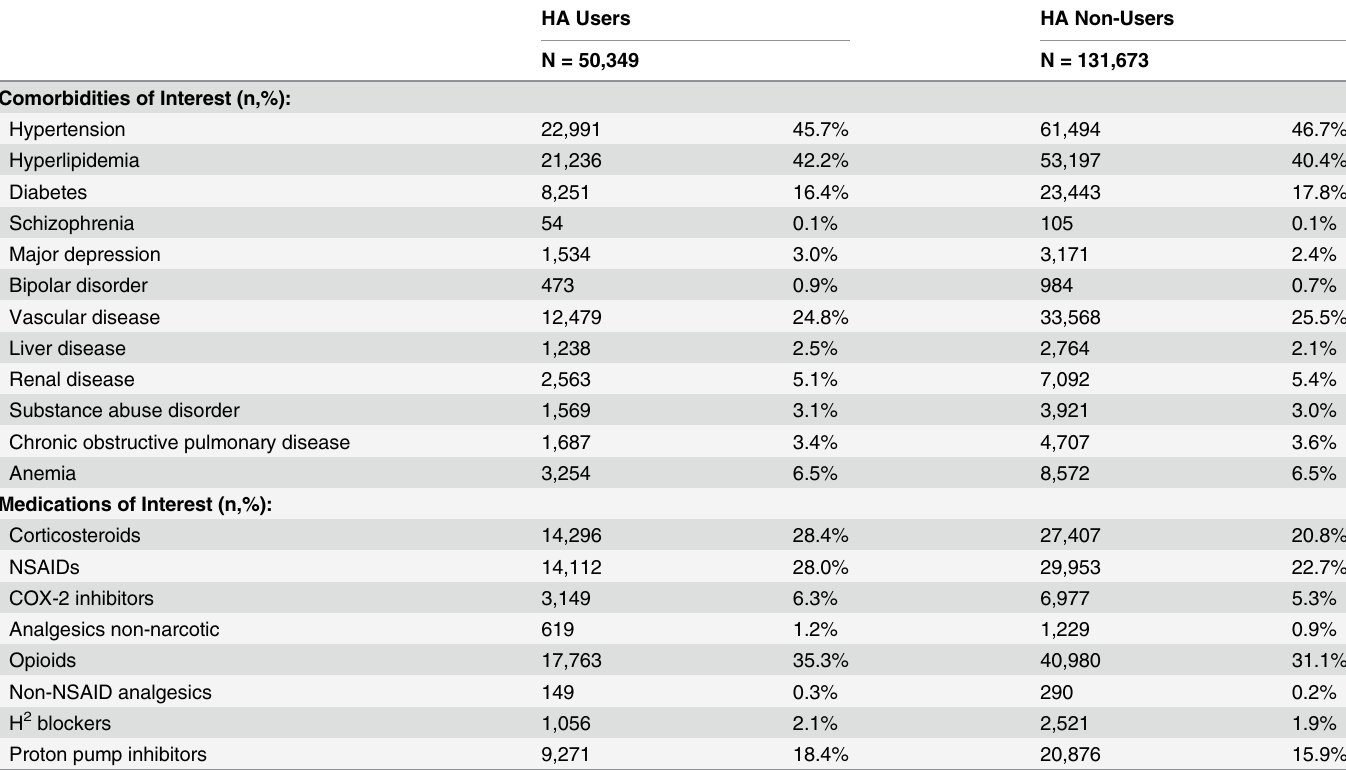
Table 4. Summary of comorbidities and medications among HA Users and HA